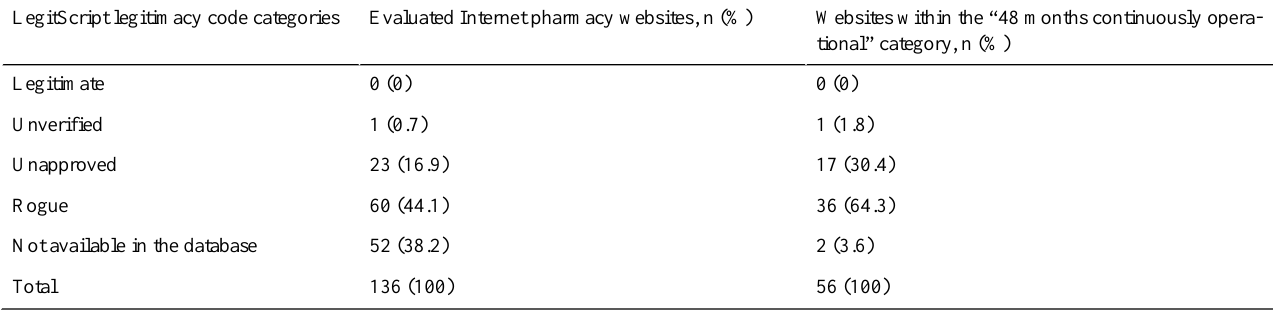
Table 3. LegitScript legitimacy code of total evaluated Internet pharmacies and continuously operational